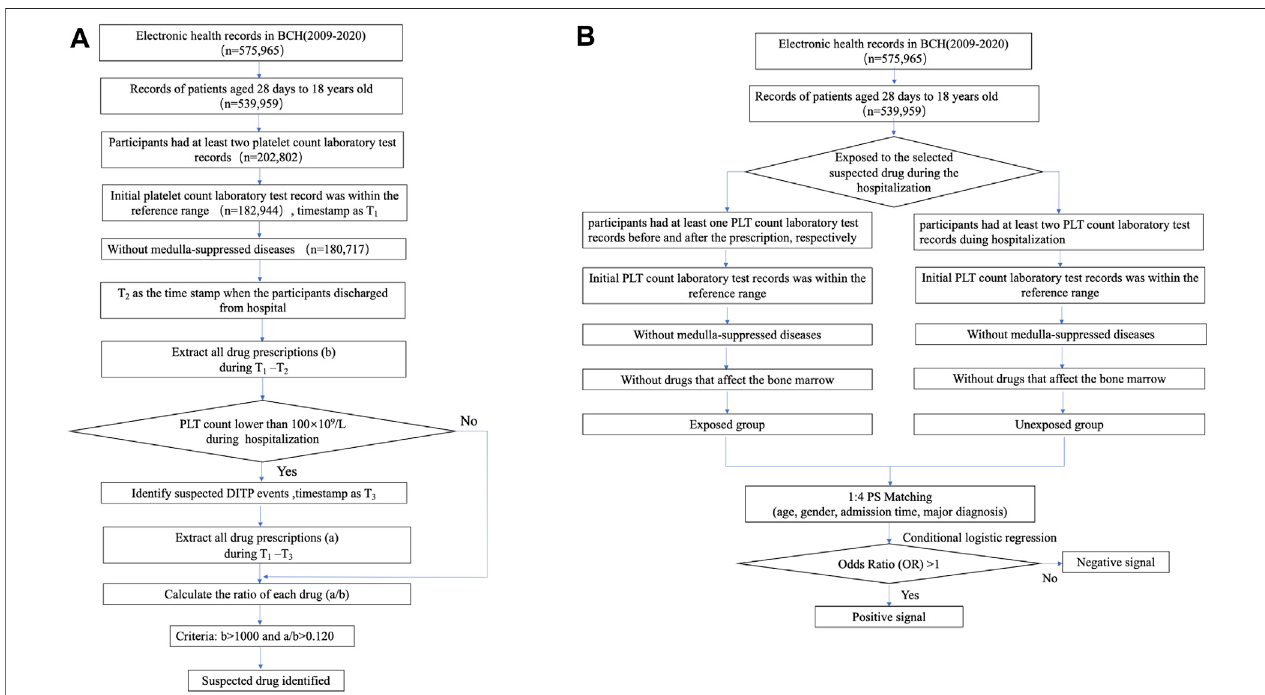
FIGURE1| Work fl owoftwo-stepsignaldetectionmethodofDITPusingEMRdata. (A) Thework fl owofstageoneforscreeningdrugspotentiallycausingDITP. (B) The overall design of stage two for the detection of DITP signals based on retrospective cohort design.